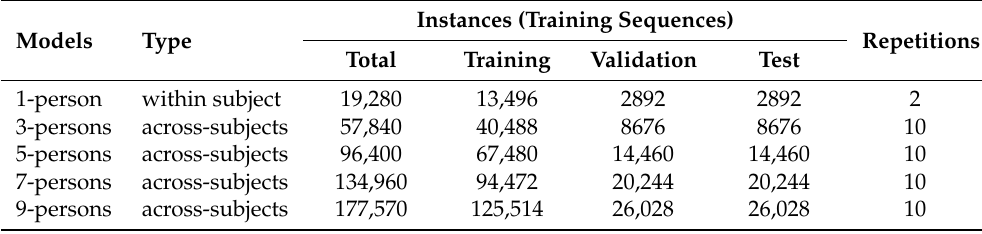
Table 1. Details of within and across-subjects models with number of training, validation and test instances, as well as the number of Monte Carlo